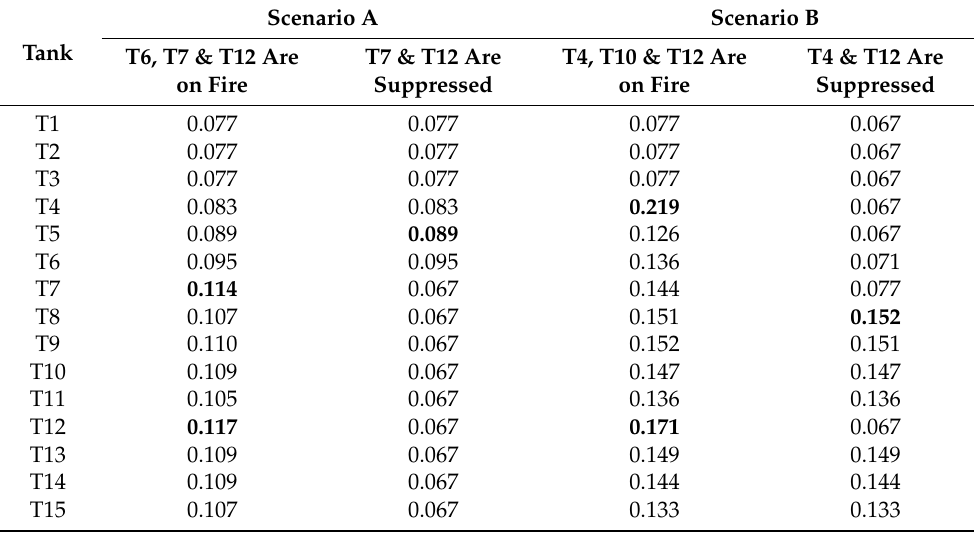
Table 7. Identification of optimal firefighting strategies based on the out-closeness scores.